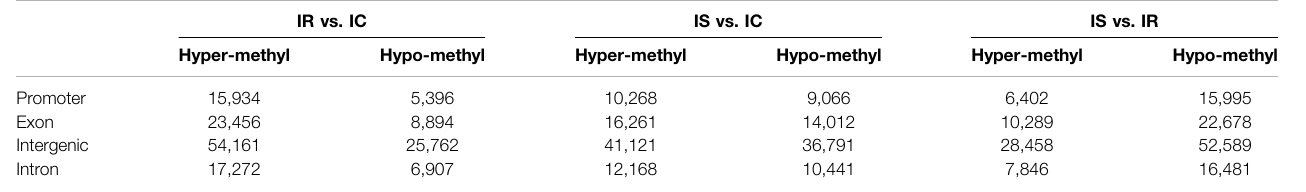
TABLE 2 | Analysis and distribution of the signi fi cant methylated genes of the IR, IS, and IC groups. IR vs. IC IS vs. IC IS vs.